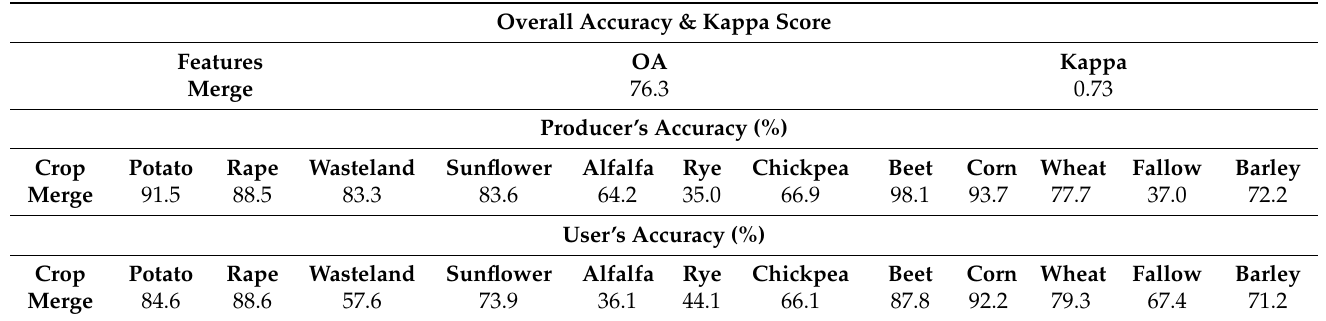
Table 7. Classification scores with 40 Sentinel-1 images and 8 PAZ